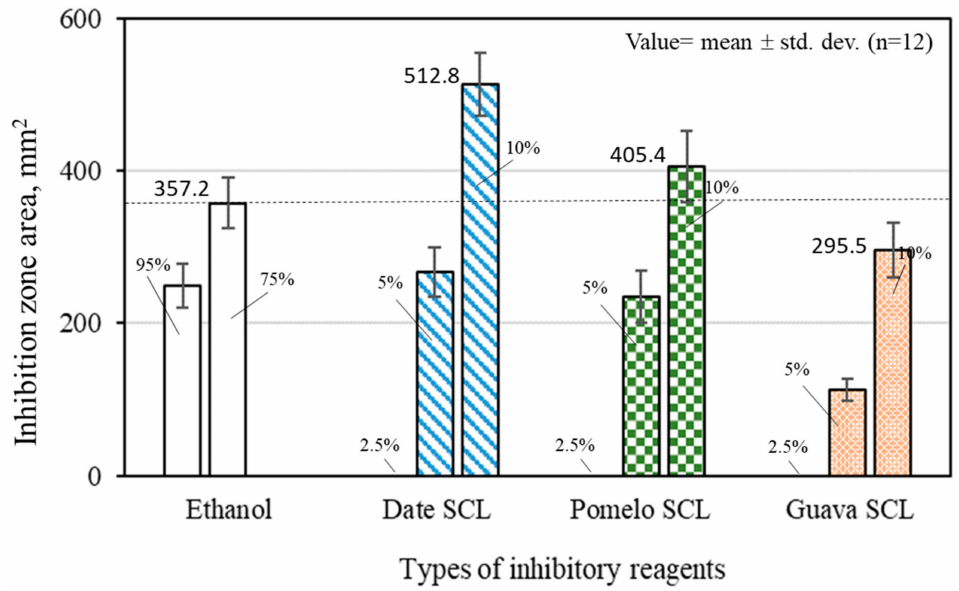
Figure 2. Size of inhibition zone due to the presence of each inhibitory reagent at various concentra- tions (ethanol dose at 95 and 75%; each SCL dose at 2.5, 5, and 10%). The dashed line indicated the inhibition zone area caused by 75%